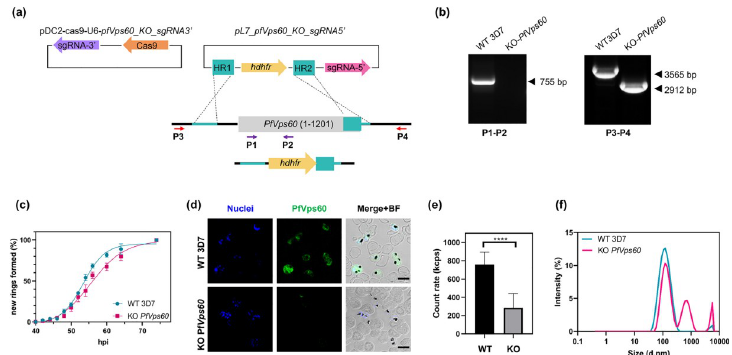
Fig 6. Generation and validation of PfVps60 KO parasites. (a) Scheme of the strategy followed to generate the transgenic lines using the CRISPR/Cas9 system. Arrows indicate the position of primers used for diagnostic PCR. (b) Diagnostic PCR confirmation of the integration of the pL7- PfVps60 _KO_sgRNA3’ plasmid at the PfVps60 locus. Legends at the bottom of each panel indicate the primer pair used for each PCR reaction. Genomic DNA from the WT 3D7 line or the PfVps60 KO transgenic line was used. The expected size of the bands is indicated on the right side of each panel. (c) Asexual blood cycle duration in the PfVps60 KO line compared with its parental 3D7 line. Percentages indicate the proportion of rings observed relative to the total number of rings at the end of the assay. Data was fitted to a sigmoidal curve with variable slope to extract the intraerythrocytic developmental cycle. (d) Human erythrocytes infected with P . falciparum were fixed and PfVps60 (green) was detected by indirect immunofluorescence microscopy. Cell nuclei were visualized with Hoechst 33342 (blue). Fields were merged with bright field (BF) to assess localization. Scale bar: 5 μ m. (e) Derived count rate of purified EVs from three independent replicates expressed in kilo counts per second (kcps). (f) Representative results of the size distribution of EVs derived from the WT 3D7 or the KO PfVps60 strains determined using a Zetasizer Nano. Each symbol shows the mean of three different replicates, bars show the SE. ���� : p < 0.0001.